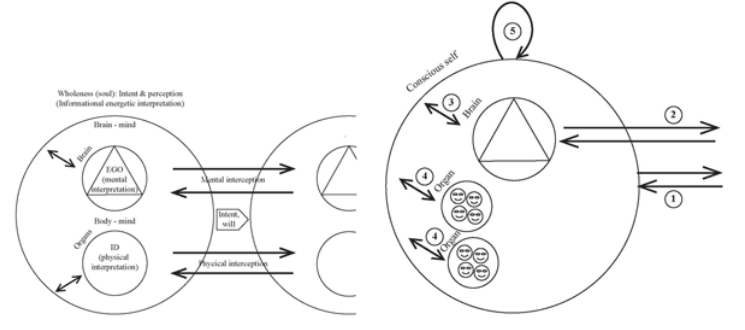
FIGURE 1. A model of the wholeness of man, including the functions of attention and will. The representational stages of a human being. The attention function and a survey over the representative possibilities and functional stages. This figure shows a survey of man. Man himself is part of a larger social system, to which it through interactions is adapted, and which he himself influences. The human organism can directly represent elements at its own level, humans and other living beings, and more difficultly dead things. The human organism is also able to represent lower levels, such as organ systems, and higher levels, such as the family. A. Wholeness, intention and perception. B. The 5 representational stages: 1. Directly representation of the outer world. 2. Indirectly representation of the outer world through the brain. 3. Representation of the brain in the wholeness. 4. Directly representation of the outer world. 5. The wholeness represents the